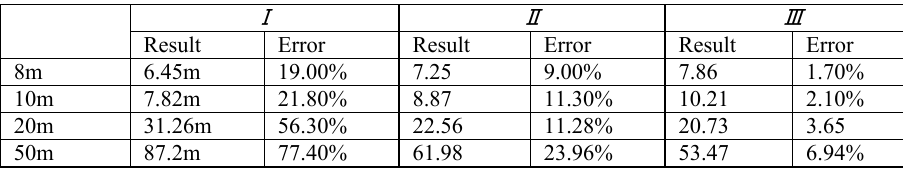
Table 2. A table with SNR and RMSE of three